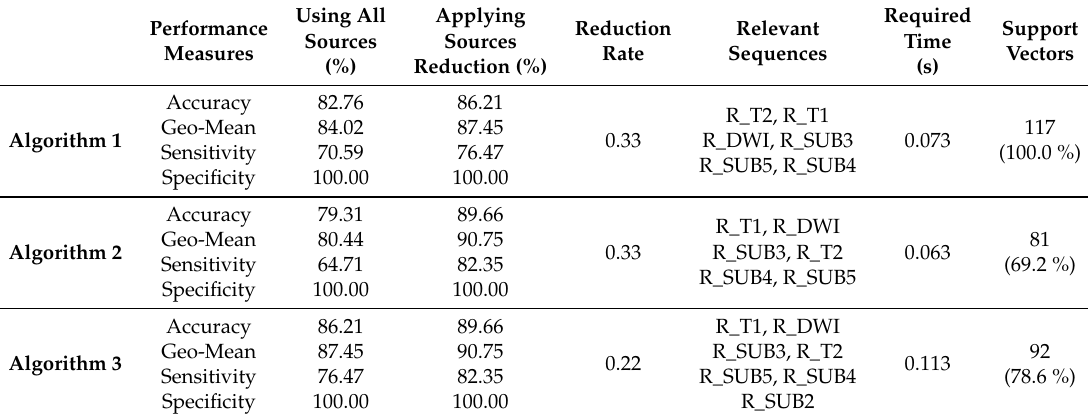
Table 6. Results of selection of MRI sequences with radiomic features and (cid:96) 1